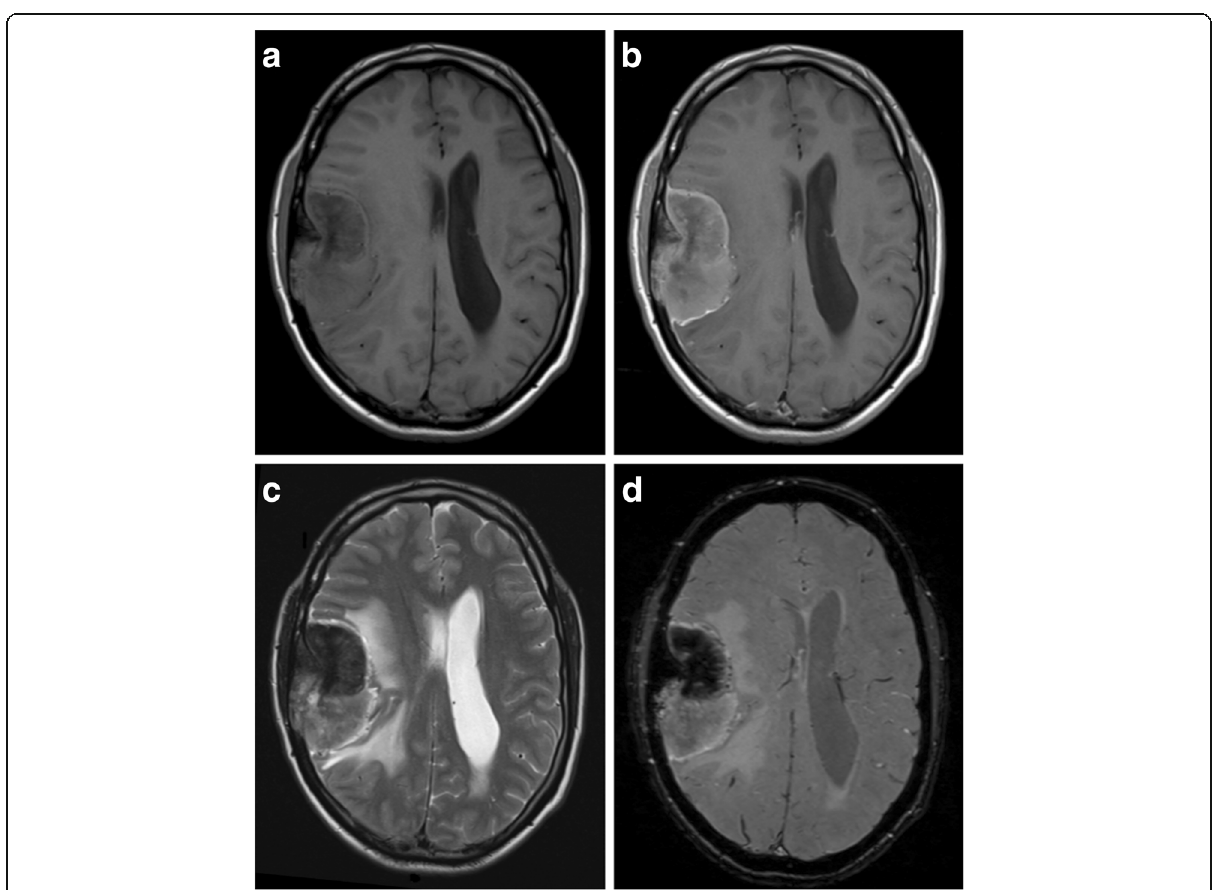
Fig. 2 Atypical meningioma. a , b Pre- and post-contrast axial T1-weighted MR images showing a heterogeneously enhancing mass with a wide dural base, CSF cleft and bony involvement. The cortical interface is less distinct when compared with Fig. 1, and there is a moderate amount of associated vasogenic oedema. c Axial T2-weighted MR image of the same lesion. d Susceptibility-weighted images show internal